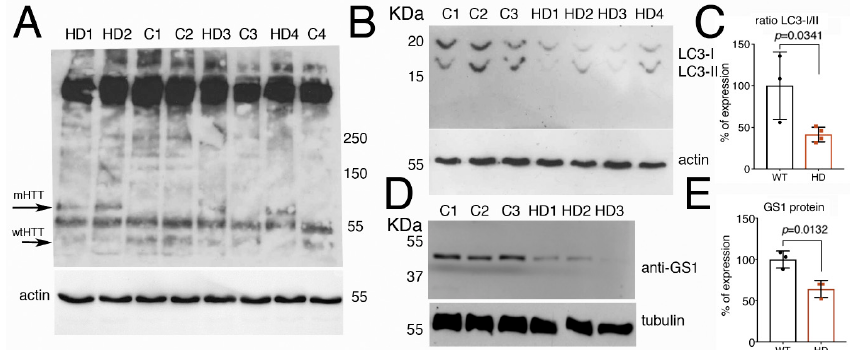
Figure 8. Fibroblasts from HD patients have reduced the expression of LC3 and GS1 proteins. ( A ) Western blot showing the pattern of expression of human Htt protein in fibroblasts from control healthy donors (C1–C3), with an average of 15–33 CAGs, or from HD patients (HD1–HD4) with an average of 78– 90 CAGs . The anti-hHtt antibodies evidence the presence of a band of about 70 kDa (mHTT) that is visible only in lysates from cells deriving from HD patients, while in the lysates form controls, a band below 55 KDa is evident and preferentially expressed in healthy donors (wt-Htt). Experiments were repeated at least twice, data were analyzed from al least three different patients or controls, and a representative situation is shown. ( B ) Western blot showing the cleavage of LC3 protein in the lysates of fibroblasts from control healthy donors and from HD patients. The fast-migrating form of LC3-II (upper panel) is significantly reduced in the extracts from fibroblasts of HD patient as compared to lysates from control donors. Actin is shown as a control for loading (lower panel). ( C ) Quantification of the ratio LC3-II/I from ( B ). ( D ) Western blot showing that expression of GS1 in fibroblasts from HD patients is reduced compared to its expression in control donors, tubulin was used as a control for loading. ( E ) relative quantification analysis of GS1 in fibroblasts from ( D ). The p values were calculated from Student’s t -test from the relative number of samples.